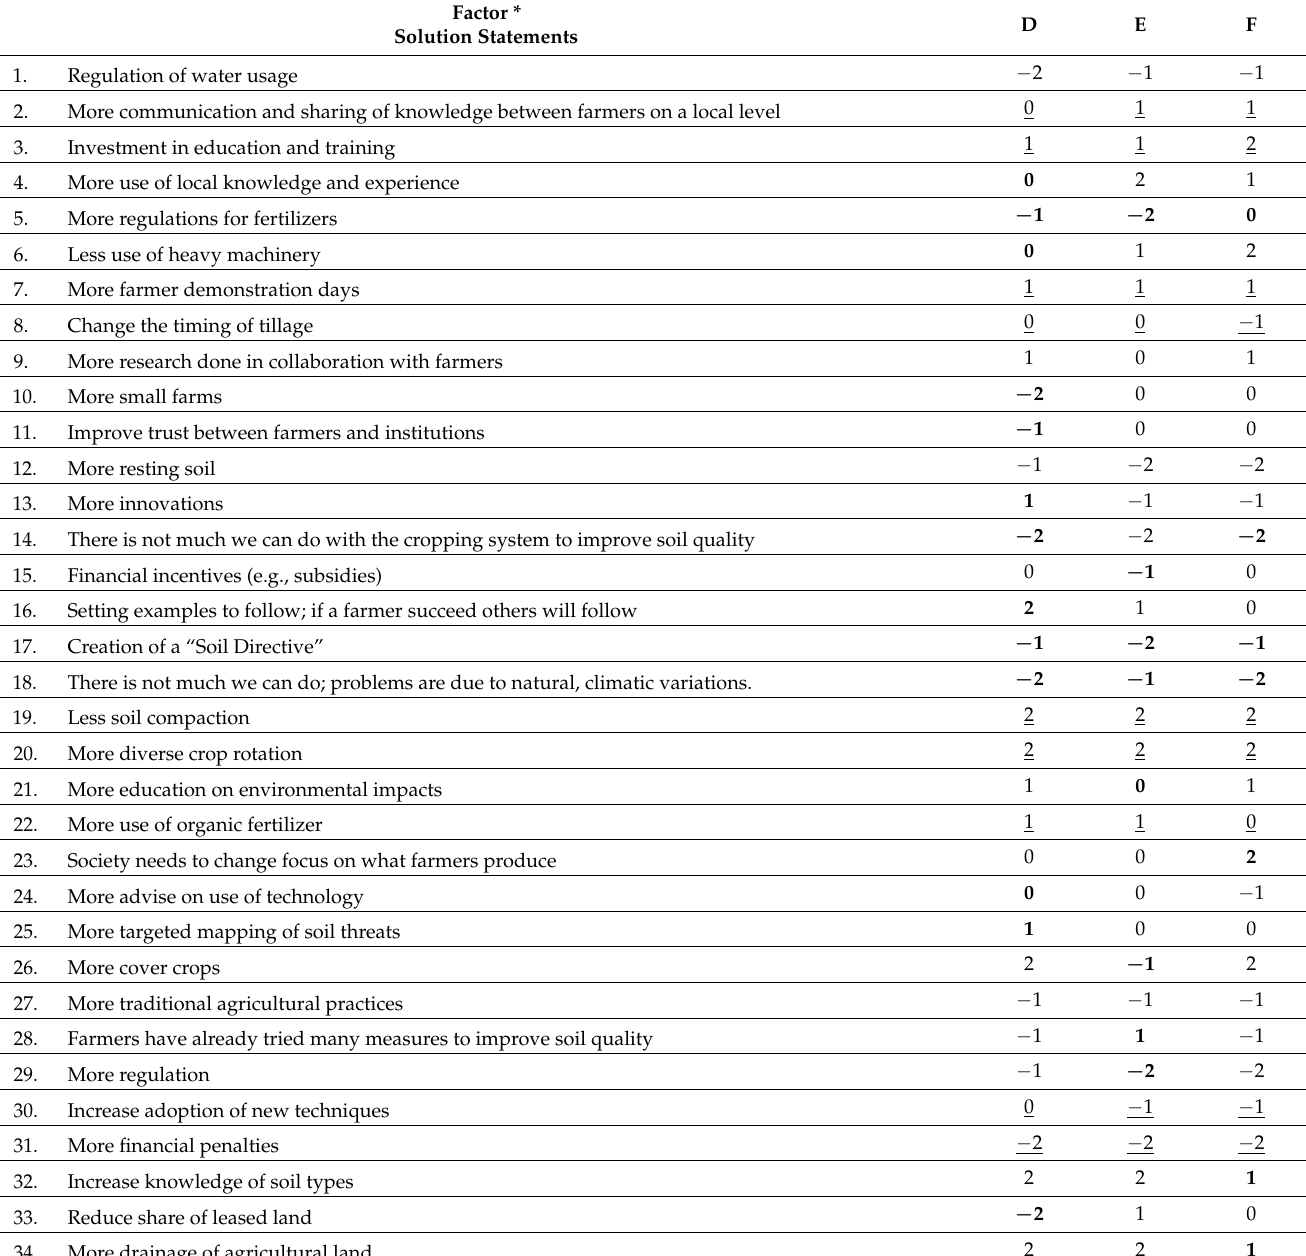
Table A4. Average Q-sort scores for each of the four factors identified as solutions to improve soil by Norwegian respondents. Bold text indicates distinguishing statement at p < 0.01, underlined text indicates consensus statements; scale from − 2 (strongly disagree) to 2 (strongly